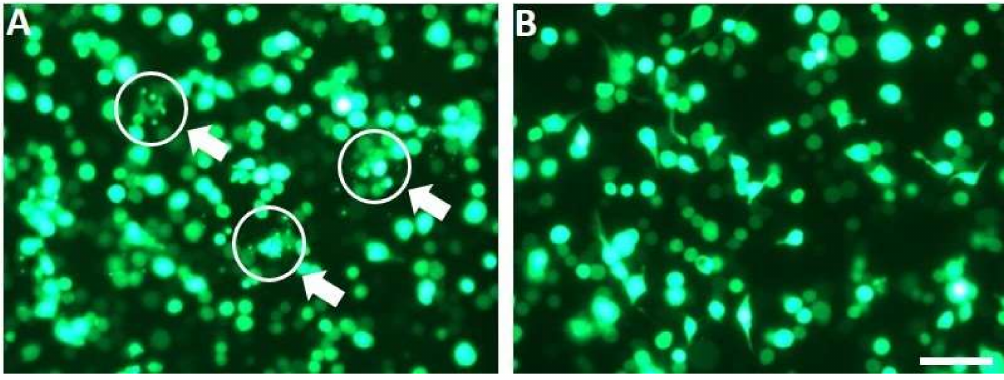
Figure 2. Caspase inhibitor carbobenzoxy-valyl-alanyl-aspartyl-(O-methyl)-fluoromethylketone (Z-VAD-FMK) blocked induction of apoptosis in Sf21 cells expressing SePTP2. EGFP expression in Sf21 cells at 48 h post transfection with pIB-SePTP2 ( A ) or with pIB-SePTP2 + Z-VAD-FMK ( B ). Apoptotic bodies are indicated by white circles and arrows, scale bar = 200 µ